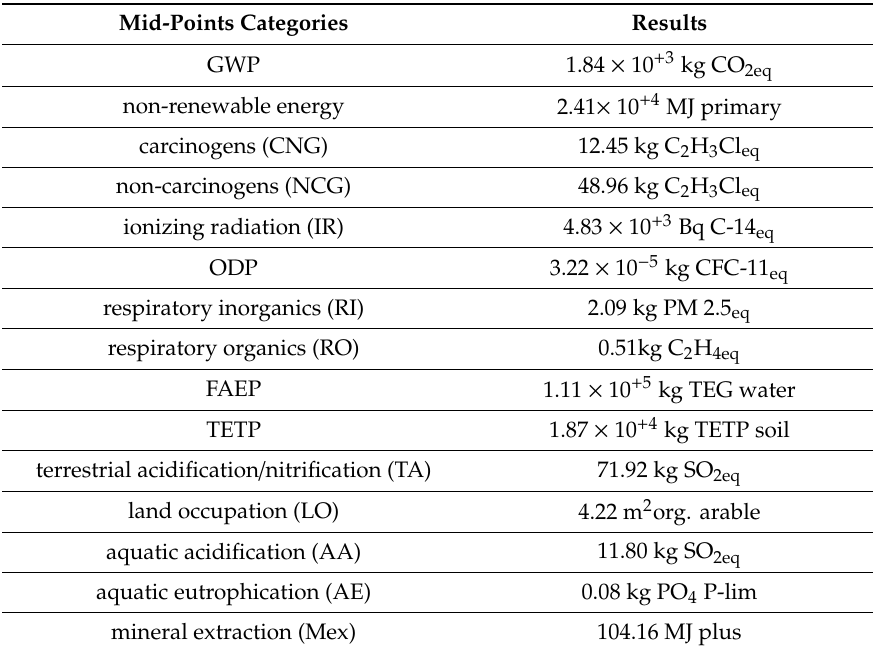
Table 5. Mid-points categories results of mc-Si PV in China (IMPACT2002 + )